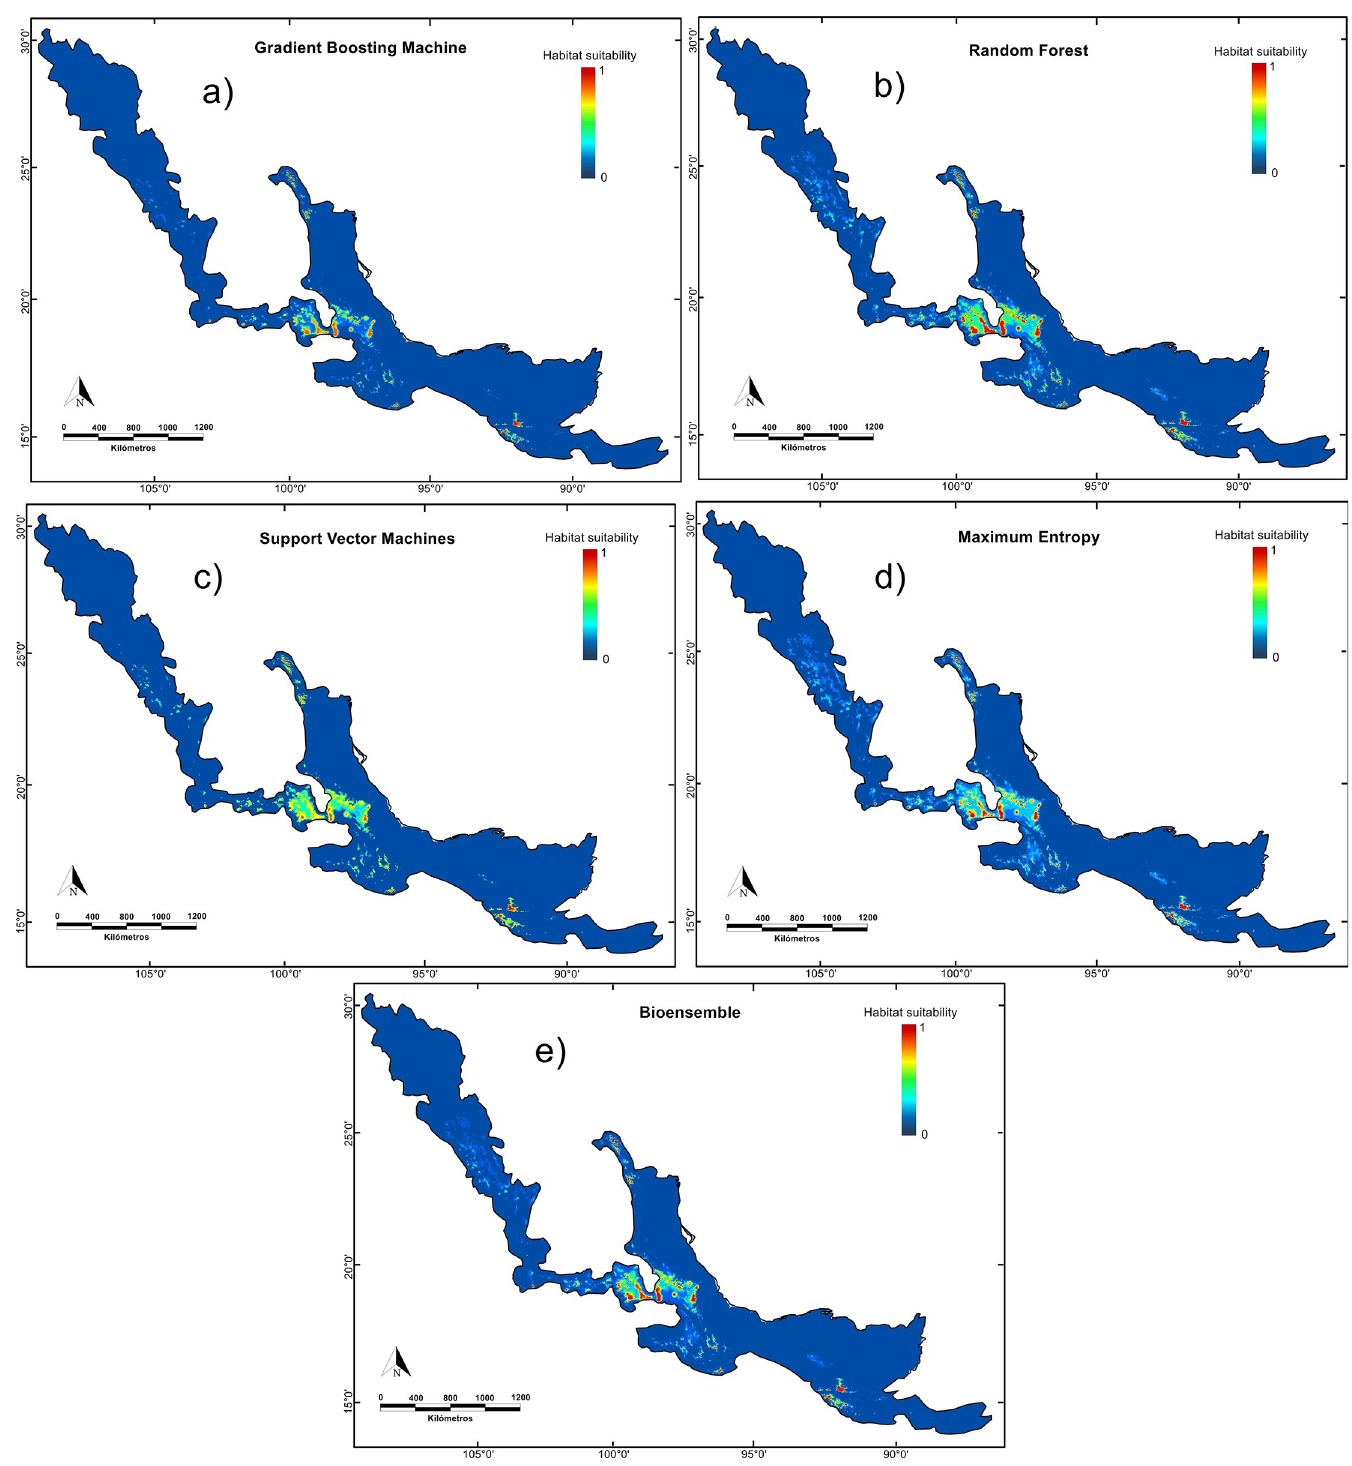
Fig 2. Potential current distribution models of P . hartwegii were constructed with the five main components that accumulate 95.77% of the data variation, generated by four algorithms: GBM, RF, SVM, and MaxEnt.